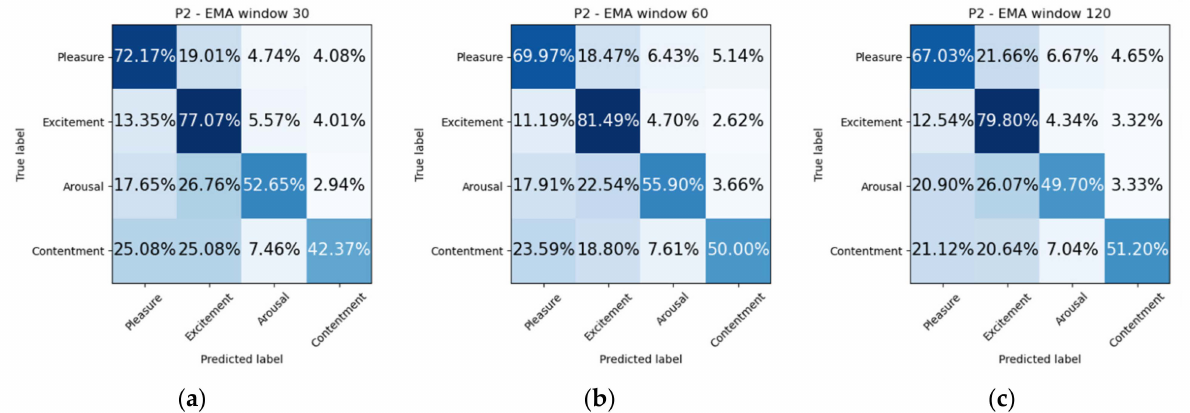
Figure 13. Confusion matrix for patient P2 for windows ( a ) 30-, ( b ) 60-, ( c ) 120-min. Predicted mood states: Pleasure, Excitement, Arousal and Contentment.